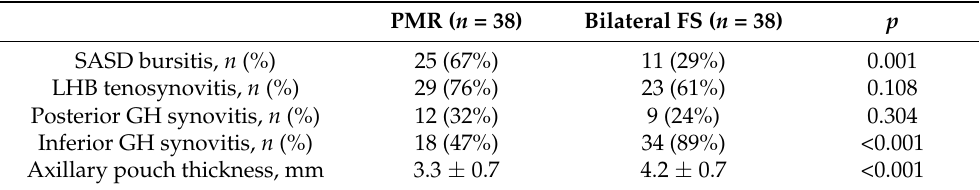
Table 2. Unilateral synovial pathologies in patients with PMR and bilateral FS.